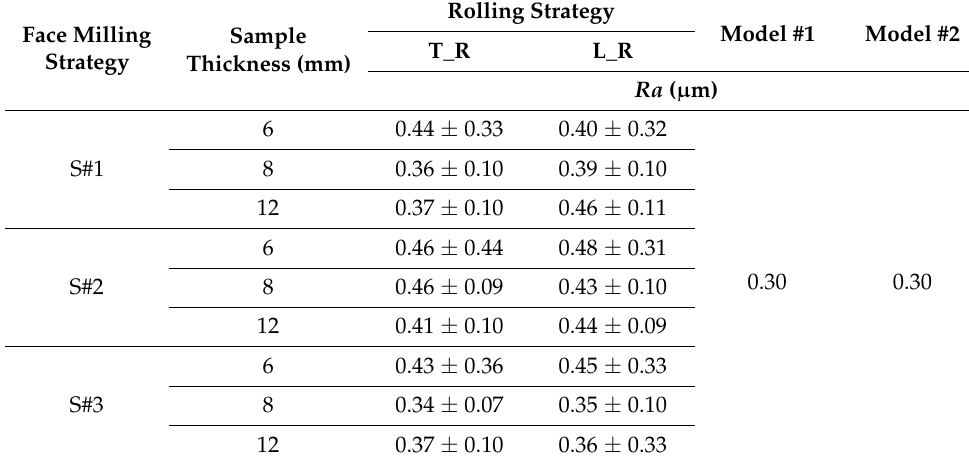
Table 6. Comparison of mathematical models and experimental surface